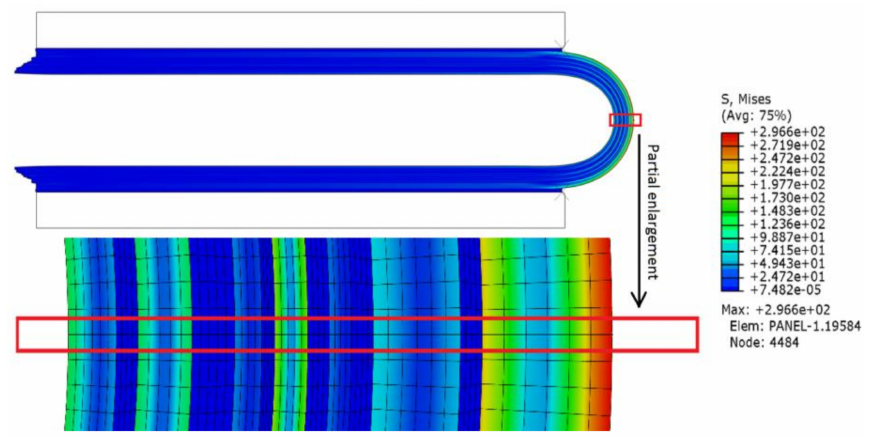
Figure 3. Mises stress distribution after downward bending.